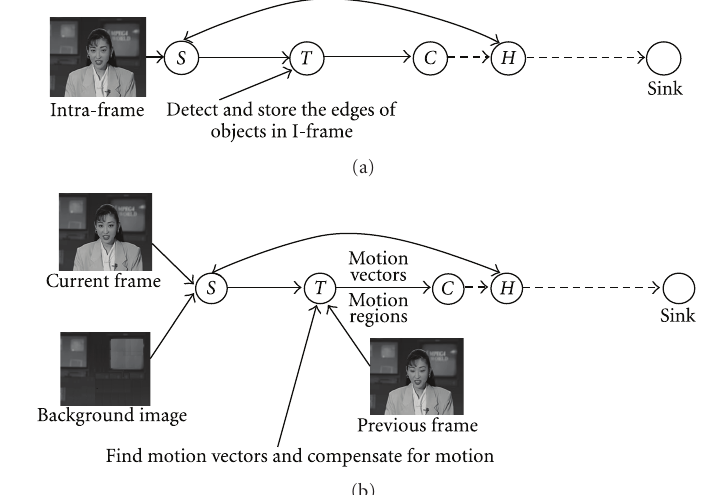
Figure 10: The normal case of the proposed video compression scheme 2 with N hops = 3 for (a) I-frames and (b) P-frames.